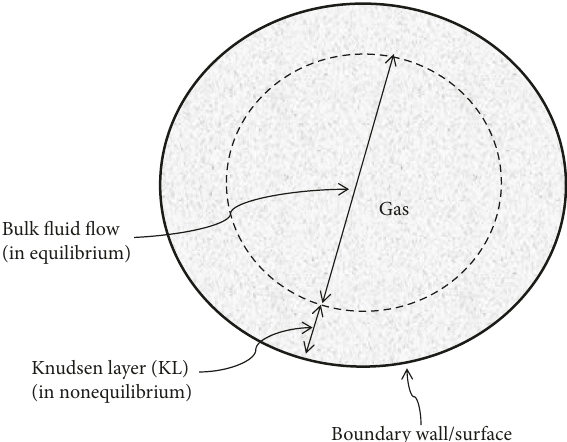
Figure 3: Schematic of the Knudsen layer near a boundary wall. The property in KL is discontinuous across which certain slip and jump conditions expressing conservation of momentum, mass, and energy are applied. The KL region is in nonequilibrium, whereas the bulk fluid flow region is in